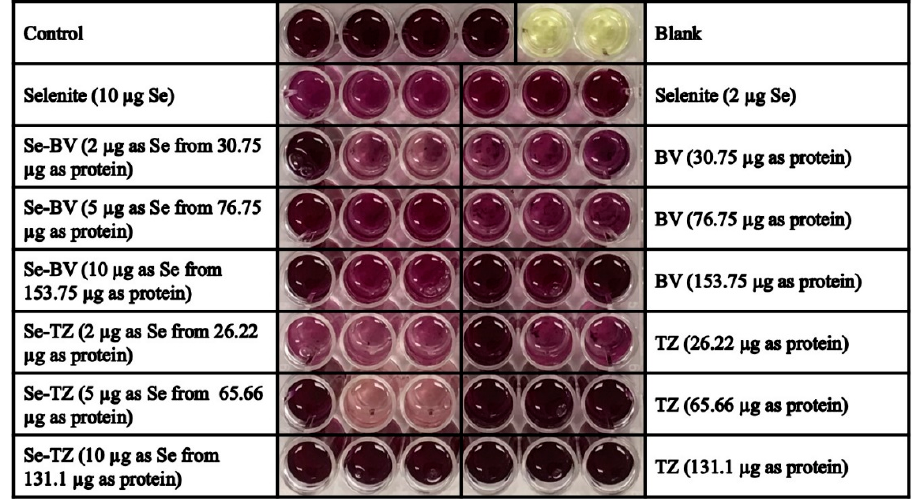
Figure A1. HME50-5E MTT Plate Photo on Day 3 Post Treatment showing the insoluble formazan salt.